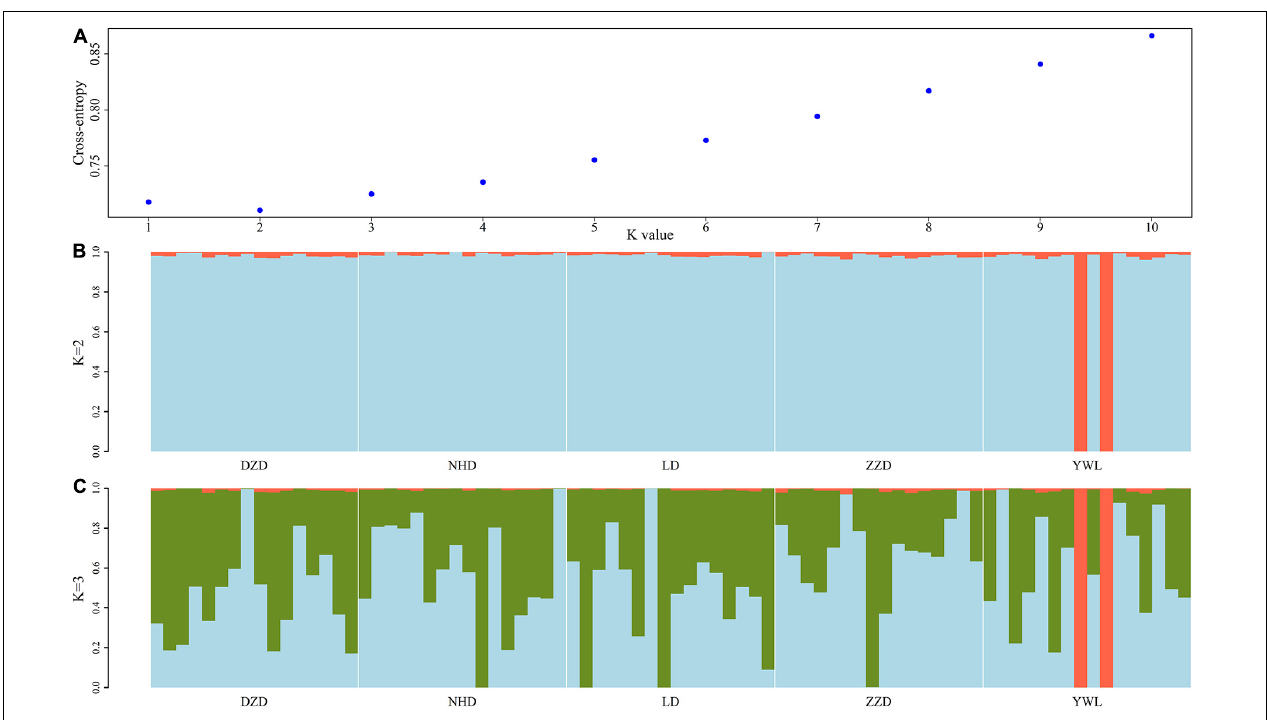
FIGURE 3 | Admixture analyses of 80 individuals based on the genome-wide single-nucleotide polymorphisms (SNPs). (A) Cross-validation plot for the number of ancestral populations (k). (B) Stacked bar plot for the k = 2. (C) Stacked bar plot for the k = 3. Each column represents an individual, and the length of colored segments denotes the proportion of an individual’s genome inherited from one of k ancestral